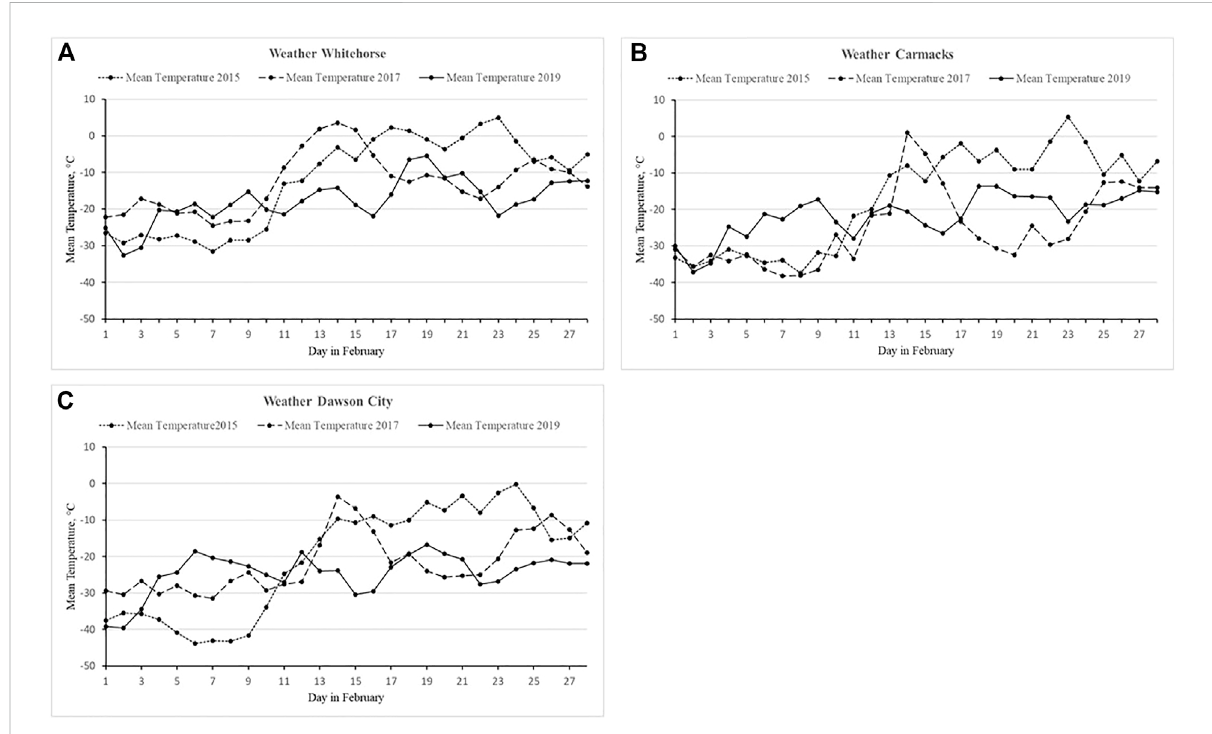
FIGURE 1 Weatherconditionsacrosseditions.MeanairtemperaturewasmeasuredinWhitehorse (A) ,Carmacks (B) andDawsonCity (C) inFebruary2015 (dotted line), February 2017 (long dashed line), and February 2019 (solid line). No signi fi cant differences between editions or